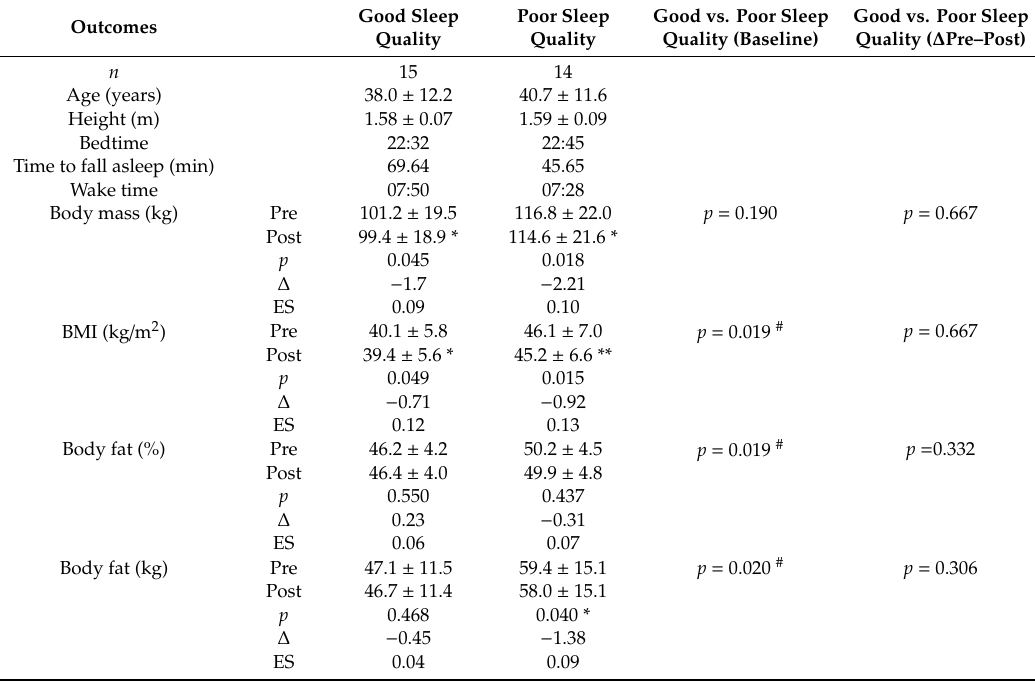
Table 2. Characteristics of the sample according to sleep